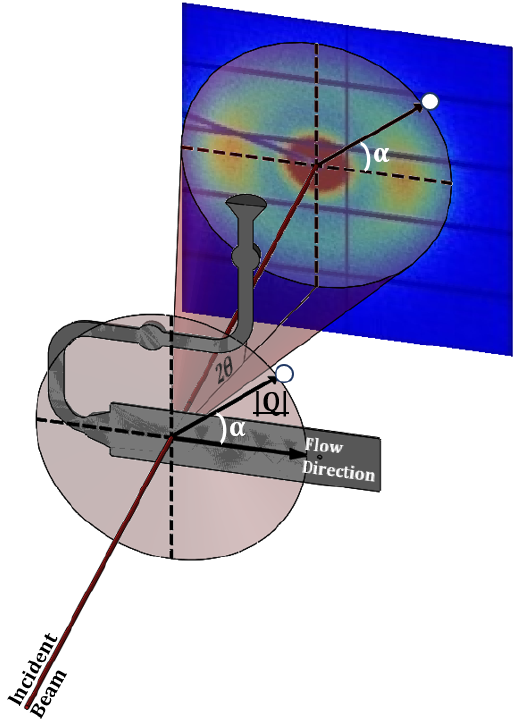
Figure 2. A schematic of the scattering geometry in the Injection Moulding System.